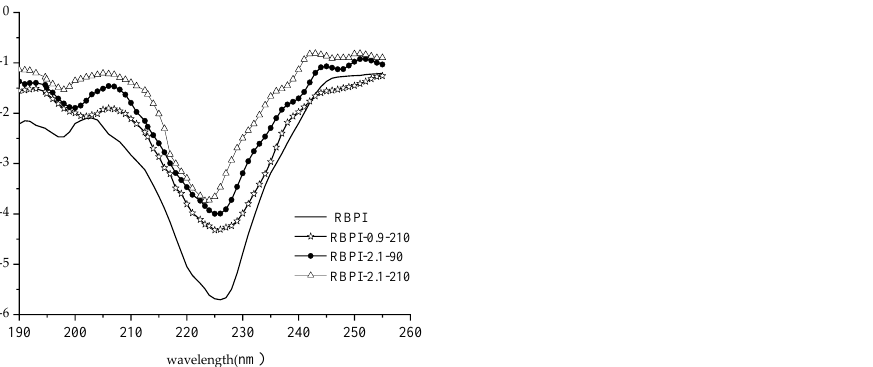
Figure 5. Circular dichroism spectra of RBPI prepared from different SFE pretreatment conditions.